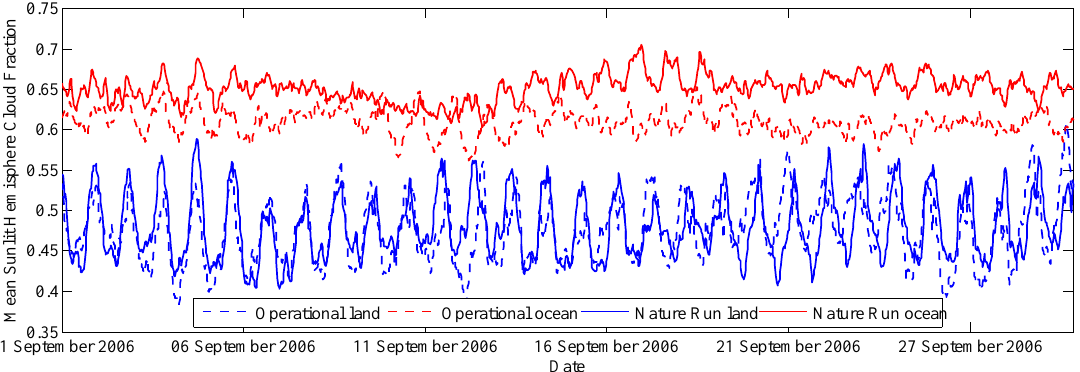
Figure 1. Comparison of land and ocean cloud fraction for the Nature Run and operational versions of GEOS-5. The time series shows the month of September